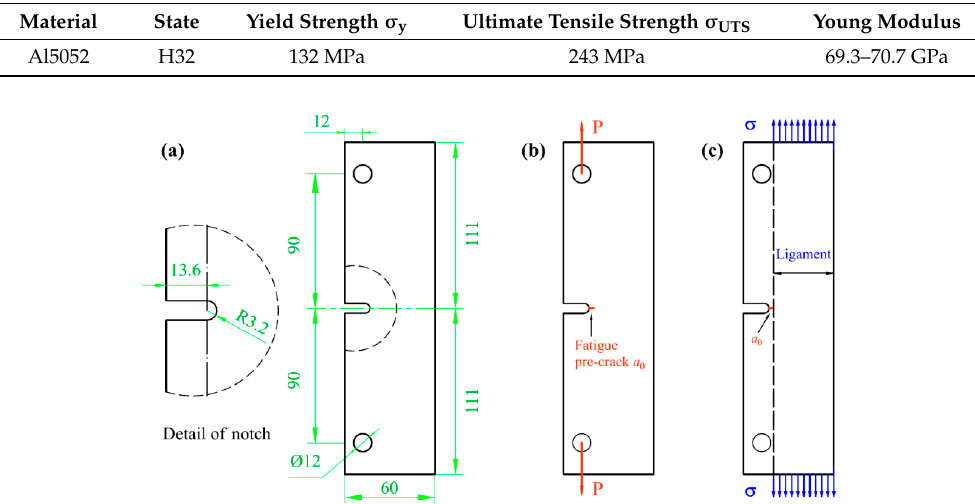
Figure 1. ( a ) The geometry and detailed dimensions of the Al-alloy specimen for measuring the stress– strain curve (in mm); and ( b ) the experimental result. Table 2. The pre-stresses applied to Extended-compact tension (E-CT) samples for fatigue testing.